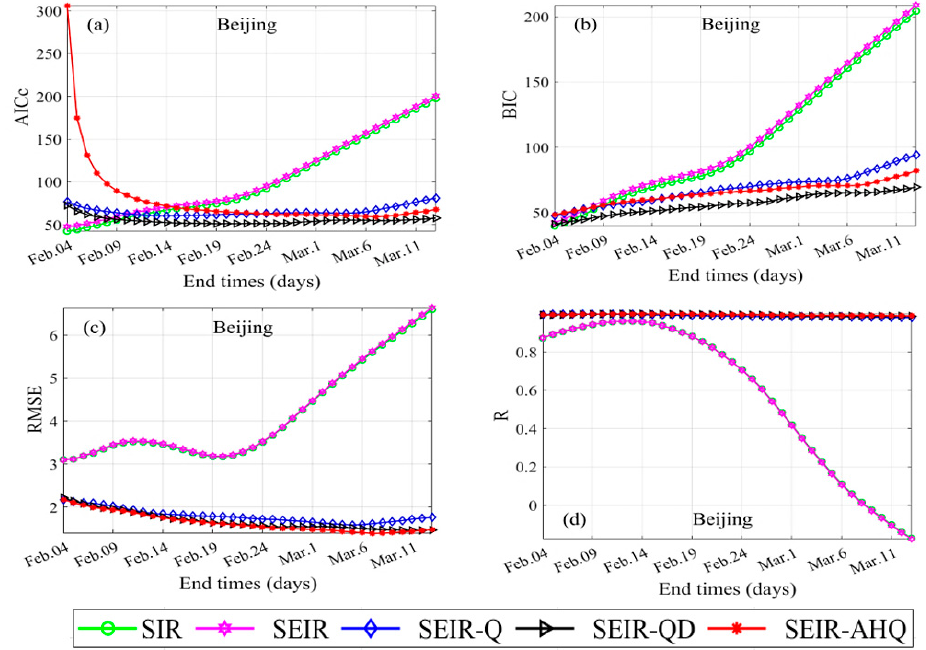
Figure 4. The values of AICc, BIC, RMSE, and R from 22 January to different end times in Beijing. ( a ) AICc; ( b ) BIC; ( c ) RMSE; ( d )